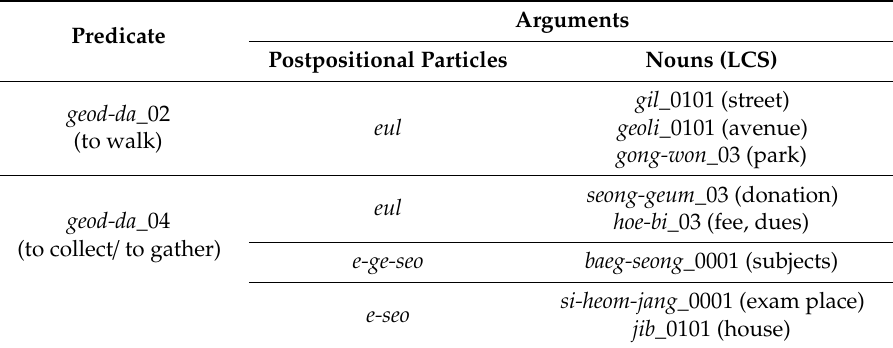
Table 6. A portion of the subcategorization of the verb “ geod-da ”.